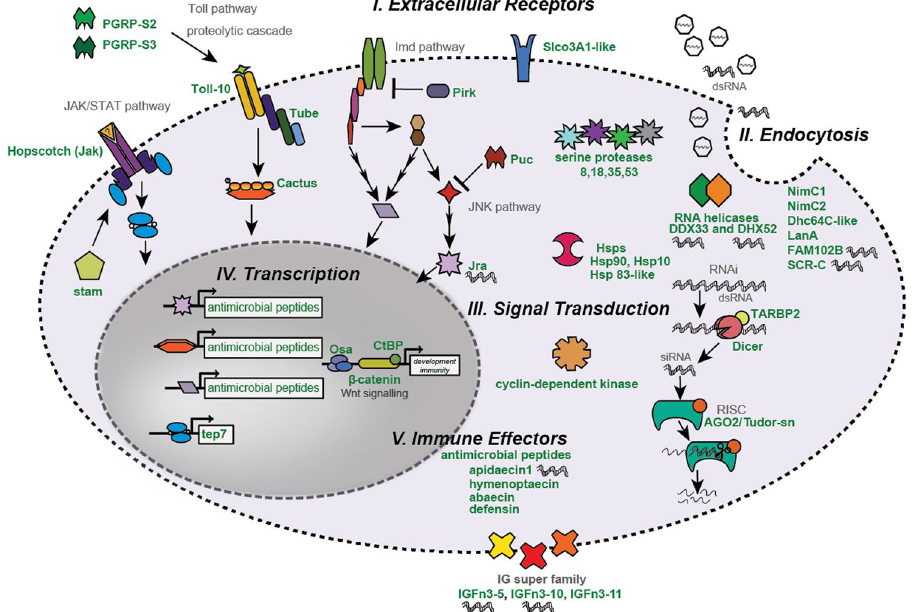
in previously characterized insect immune pathways: RNAi, Toll, JAK/STAT (Janus Kinase and Signal Transducer and Activator of Transcription), Imd (Immune Deficiency), and JNK (c-Jun N-terminal kinases) 29, 56 . This analysis determined that many genes encoding extracellular receptors, proteins involved in endocytosis, signal transduction, and immune responses exhibited increased expression; these DEGs (denoted by bold and green font) are depicted in a cellular context. Many genes exhibited higher fold change in bees treated with both virus and dsRNA as compared to bees infected with virus only (denoted with dsRNA), suggesting their involvement in dsRNA-triggered immune responses. Complete DEG lists are provided in Supplementary Table